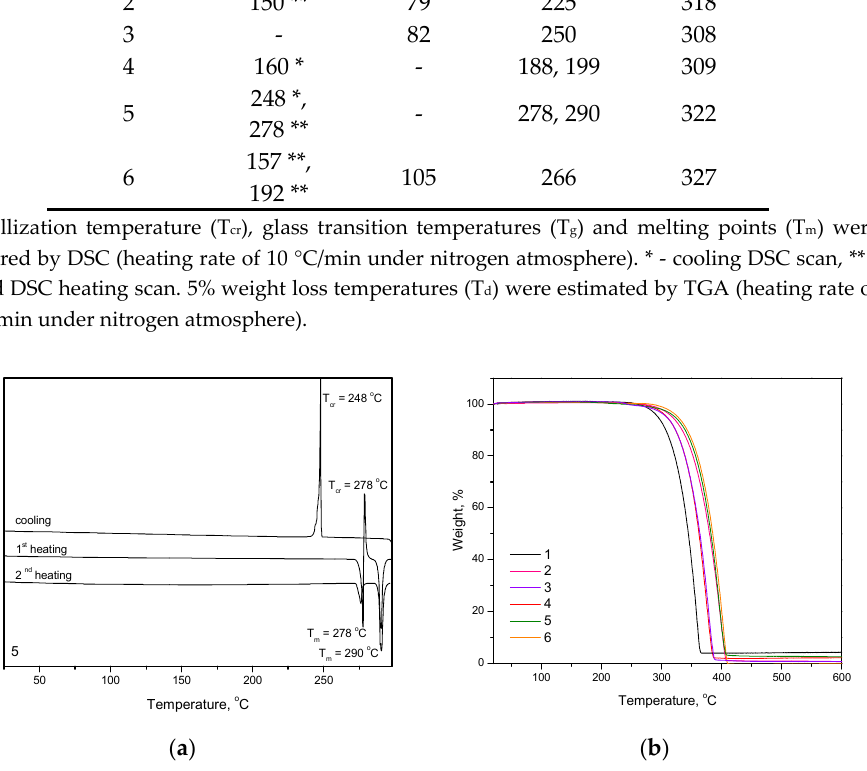
Figure 1. ( a ) DSC curves of compound 5 (scan rate of 10 °C/min. N 2 atmosphere) and ( b ) TGA curves of compounds 1 – 6 (scan rate of 20 °C/min. N 2